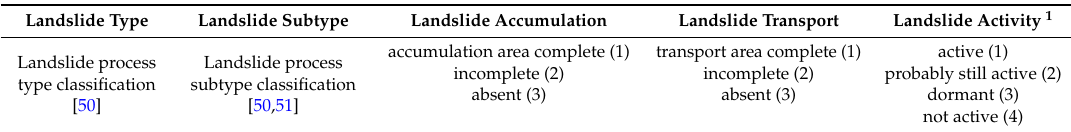
Database fields that describe the geomorphological aspects of the manually digitized